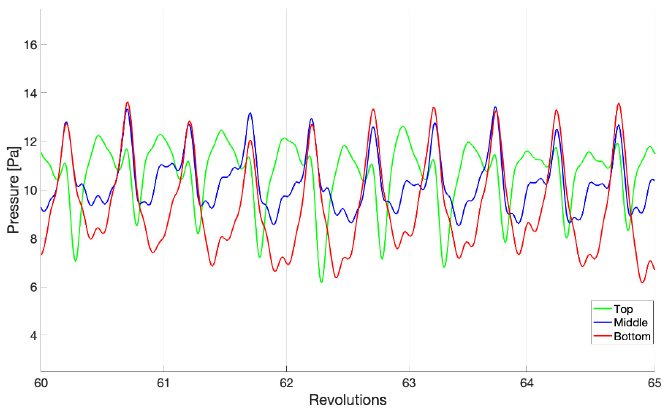
Figure 9. The average pressure for each coupon row for revolutions 60–65. The pressure was ad- justed by approximately removing the hydrostatic contribution, leaving the static and dynamic pressures caused by the motion of the baffle.